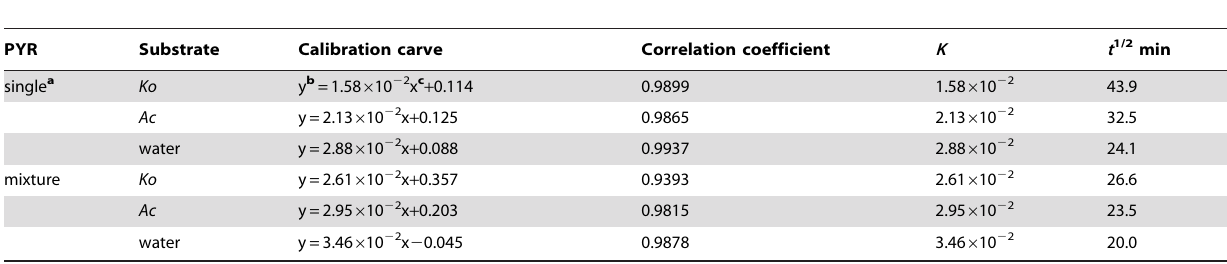
Table 2. Kinetic results of the photodegradation of PYR adsorbed onto the leaves of two typical mangrove species (n= 9) and dissolved in water (n=9) as single compounds and in multicomponent